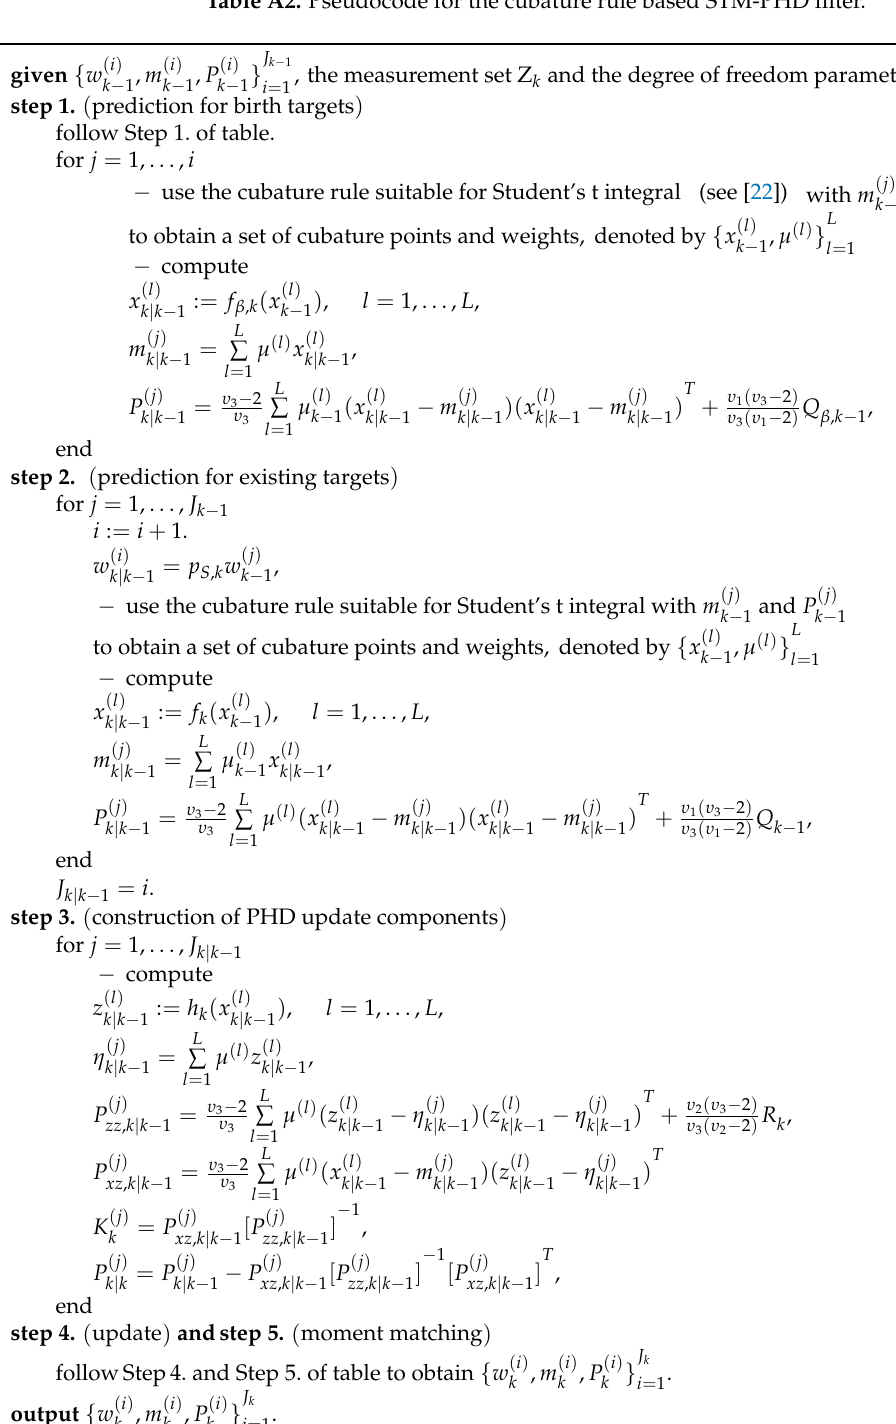
Table A2. Pseudocode for the cubature rule based STM-PHD